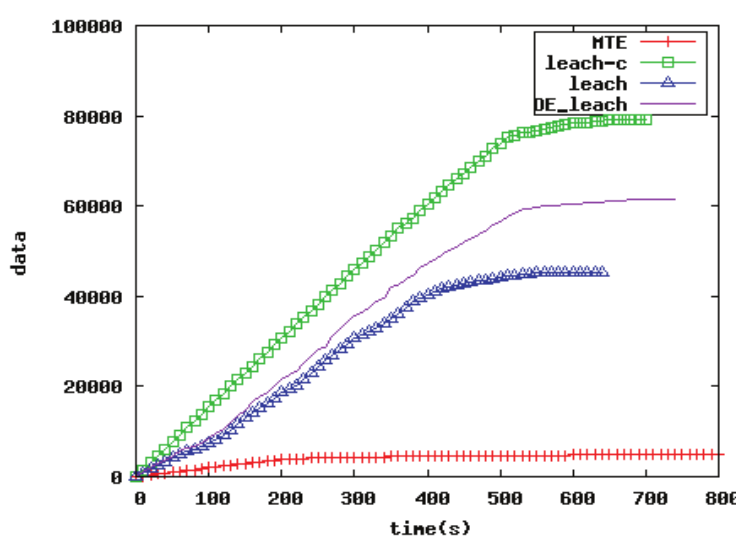
Figure 6. Comparisons of WSN